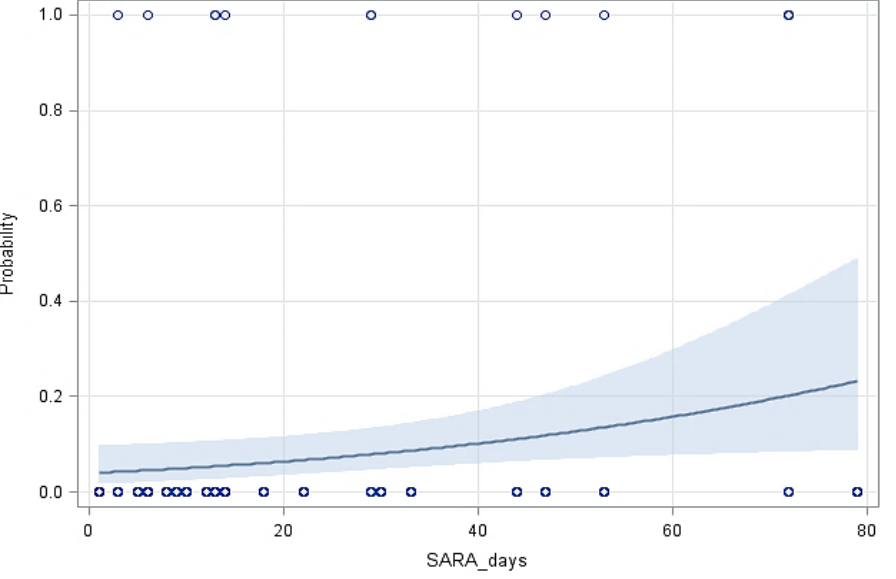
Figure 3. The receiver operating characteristic curve (ROC) of the model at various decision thresh- olds with the AUC of the model. 3.3. Type and Prevalence of Claw Lesions The types and prevalences (at claw level) of claw lesions documented at the three hoof trimming visits in the three SARA groups are listed in Table 4. The causes of lameness episodes were double soles, white line lesions, acute digital dermatitis (DD - M2), and one single sole ulcer. This sole ulcer was diagnosed at hoof trimming before calving in a heifer in the severe SARA group. Concave dorsal walls of the claws of all cows in the three SARA groups were only documented at hoof trimming visit 2 (i.e., at the end of the high - concentrate feeding pe- riod at 70 DIM) with a mean prevalence of 3.1%, and at visit 3 with a mean prevalence ranging from 23.4% to 28.1% (Table 4). However, statistically significant differences re- garding prevalences of concave dorsal walls across SARA groups were not detected, but statistically significant differences were observed between hoof trimming visits 2 and 3 in the light ( p = 0.022), moderate ( p = 0.032), and severe SARA groups ( p = 0.010), and between visits 1 and 3 in all three SARA groups ( p = 0.040 to 0.004).